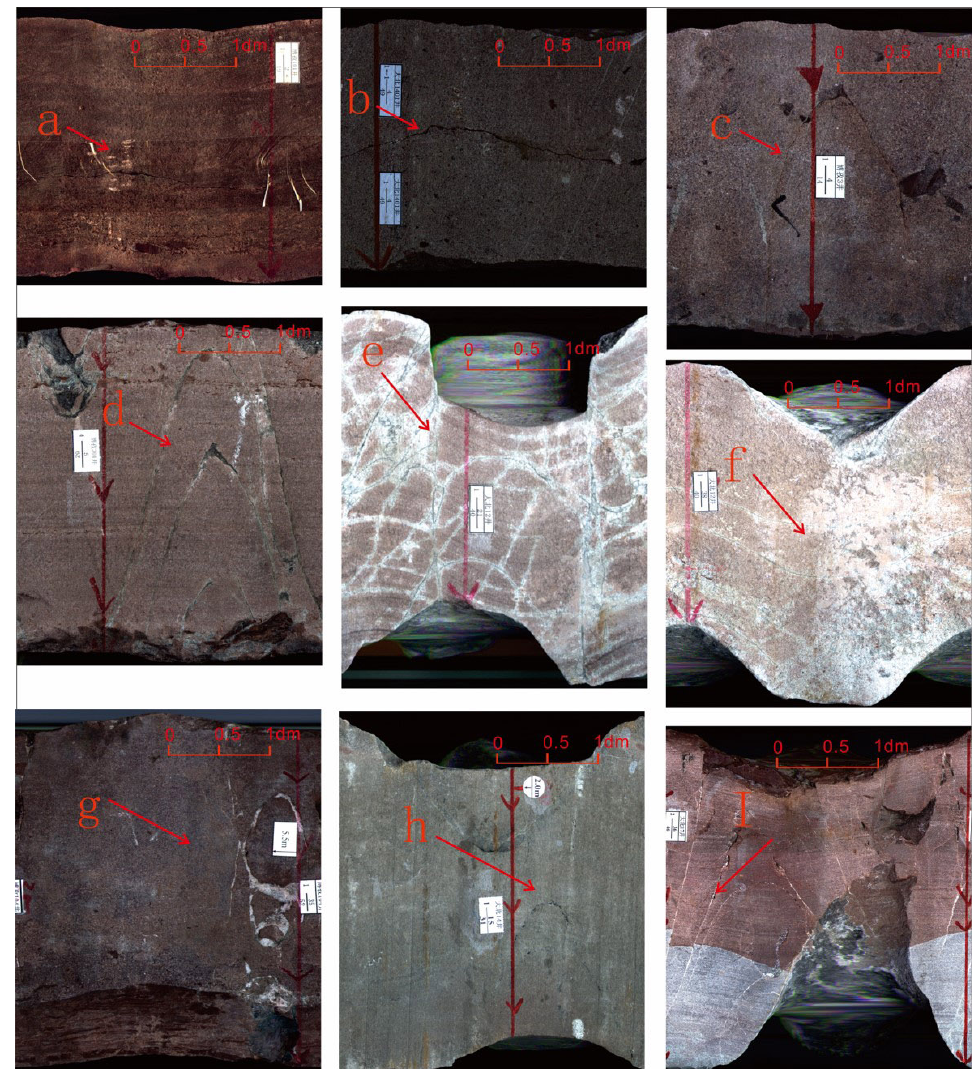
Figure 7. Core photos showing the various attributes and status of fracture. (a) Horizontal fracture, fine-grained sandstones, Bozi 101, 6916.5m. (b) Low-angle fracture, fine-grained sandstones, Dabei 1401, 6351.4m. (c) High-angle fracture, fine-grained sandstones, Bozi 3, 5972m. (d) Multi-set high-angle fracture, medium-grained sandstones, Bozi 301, 5854.2m. (e) Network fractures, medium-grained sand- stones, Dabei 12, 5399.9m. (f) Low-angle fracture, medium-grained sandstones, Dabei 12, 5403.7m. (g) Calcite-filling high-angle fracture, fine-grained sandstones, Bozi 104, 6803m. (h) Fracture-enhanced dissolution, Dabei 14, 6349.6m. (i) Calcite filling and dissolution along the fracture planes, Dabei 17,